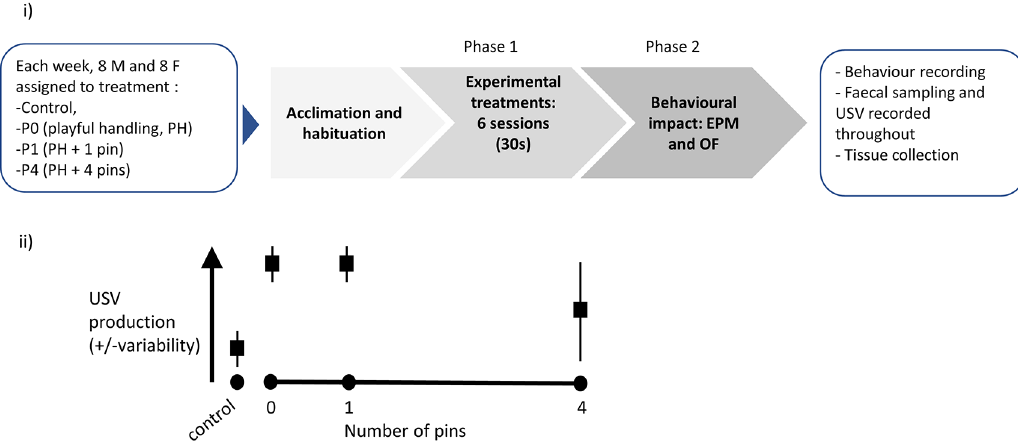
Figure 3. Experimental plan and graphical illustration of hypothesis. (i) Graphical representation of the exper- imental protocol. Upon reception, each cohort (n=4 cages, with two males per cage and n=4 cages, with two females per cage) is attributed to cage and treatment, then left to acclimatise for a week. Phase 1 consists of exposure to six sessions (30 seconds daily) of either Control, P0, P1 or P4 treatment (varying in the number of pins administered relative to background playful handling; see Objective 1 above). Finally, the rats are behaviourally tested in Phase 2, using Elevated Plus Maze (EPM) then Open Field (OF), and sacrificed for tissue collection. A step-by-step protocol is outlined in box 1. (ii) Prediction against which our confirmatory hypothesis will be tested: we predict P0 and P1 treatments will lead to higher and less variable induction of ultrasonic vocalisation (USV) production, compared